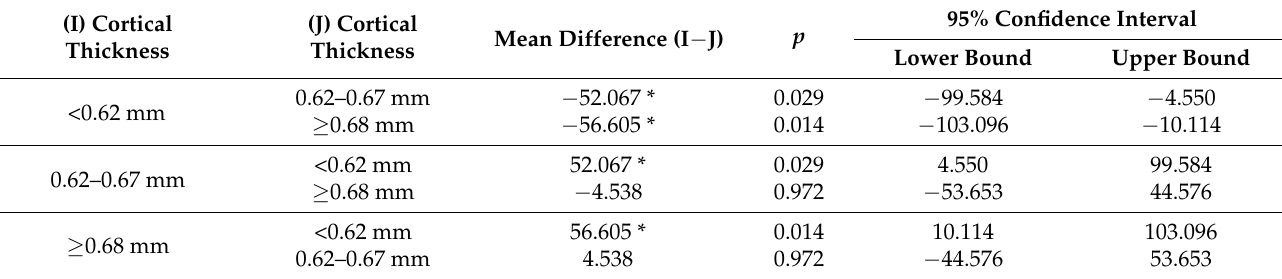
Table 4. Multiple post-hoc comparisons (Scheffe test)—cortical